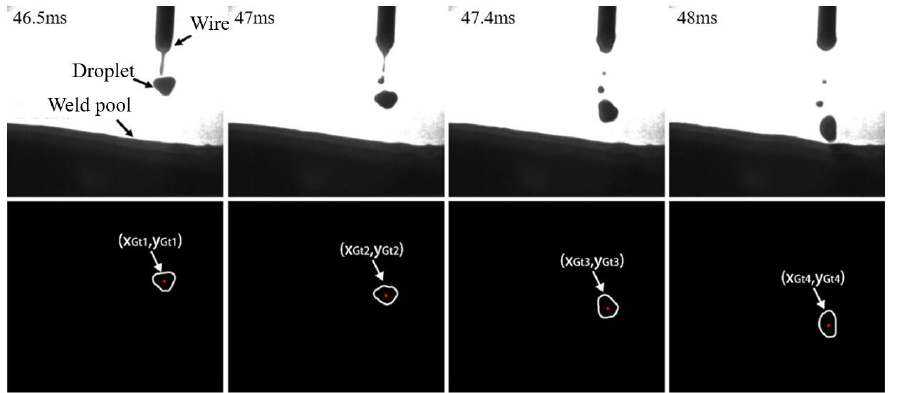
Figure 2. The droplet center of gravity position at a different time during P-GMAW welding.